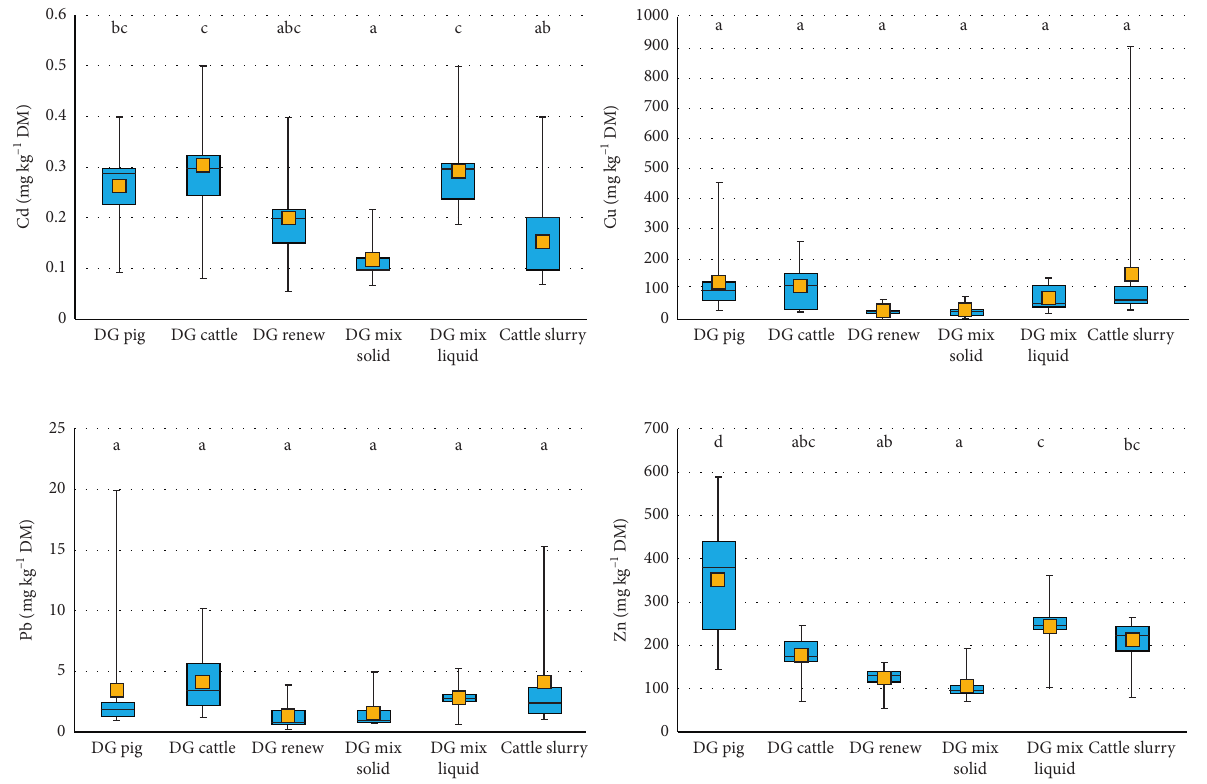
Figure 2: Range of contents of cadmium, copper, lead, and zinc in five digestates and cattle slurry (analyzed twice a year over six years; therefore, n � 12 (DG Mix liquid five years, n � 10). Different letters above bars mark significant differences between means (Scheff´e’s test, p ≤ 0 . 05)). Yellow boxes mark the mean